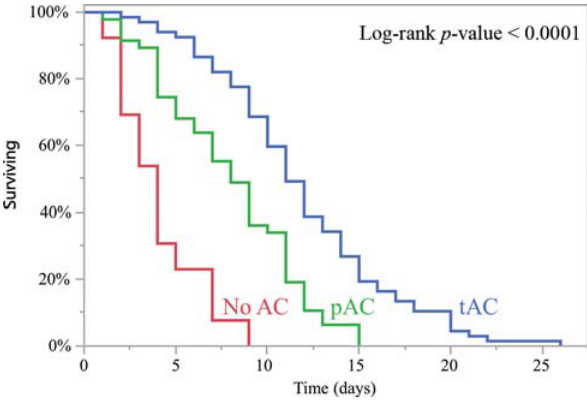
Fig. 2 Kaplan – Meier analysis of time to death in patients who received therapeutic (tAC), prophylactic (pAC) or no anticoagulation (AC).